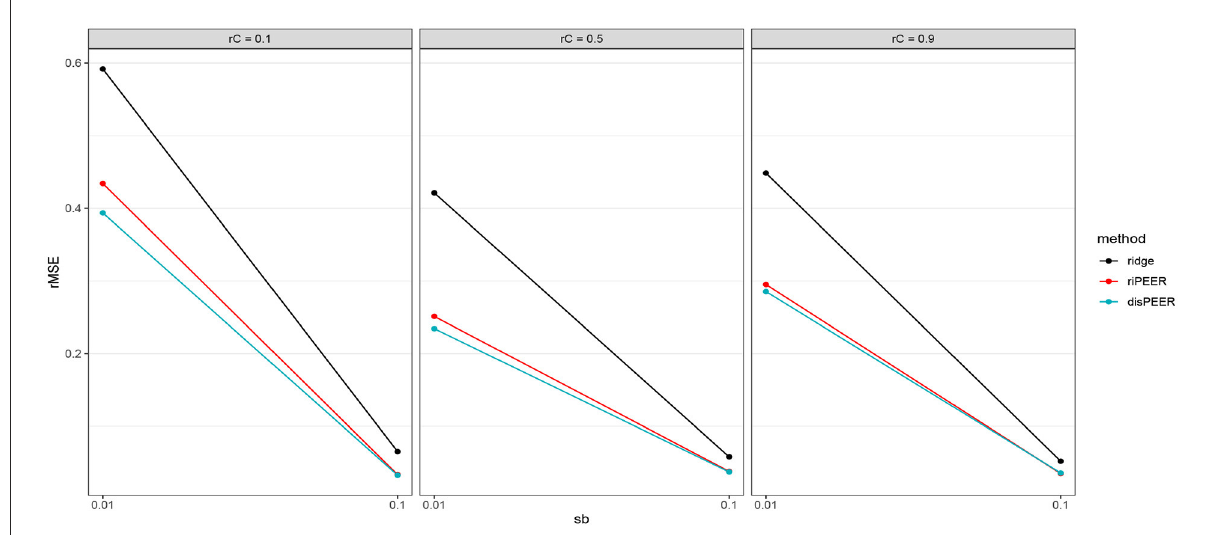
FIGURE6 Plots of rMSE (medians) of b estimates for different connectivity information configurations r C h 5 for ridge , riPEER , and disPEER ( left hemisphere and Euclidean distance =